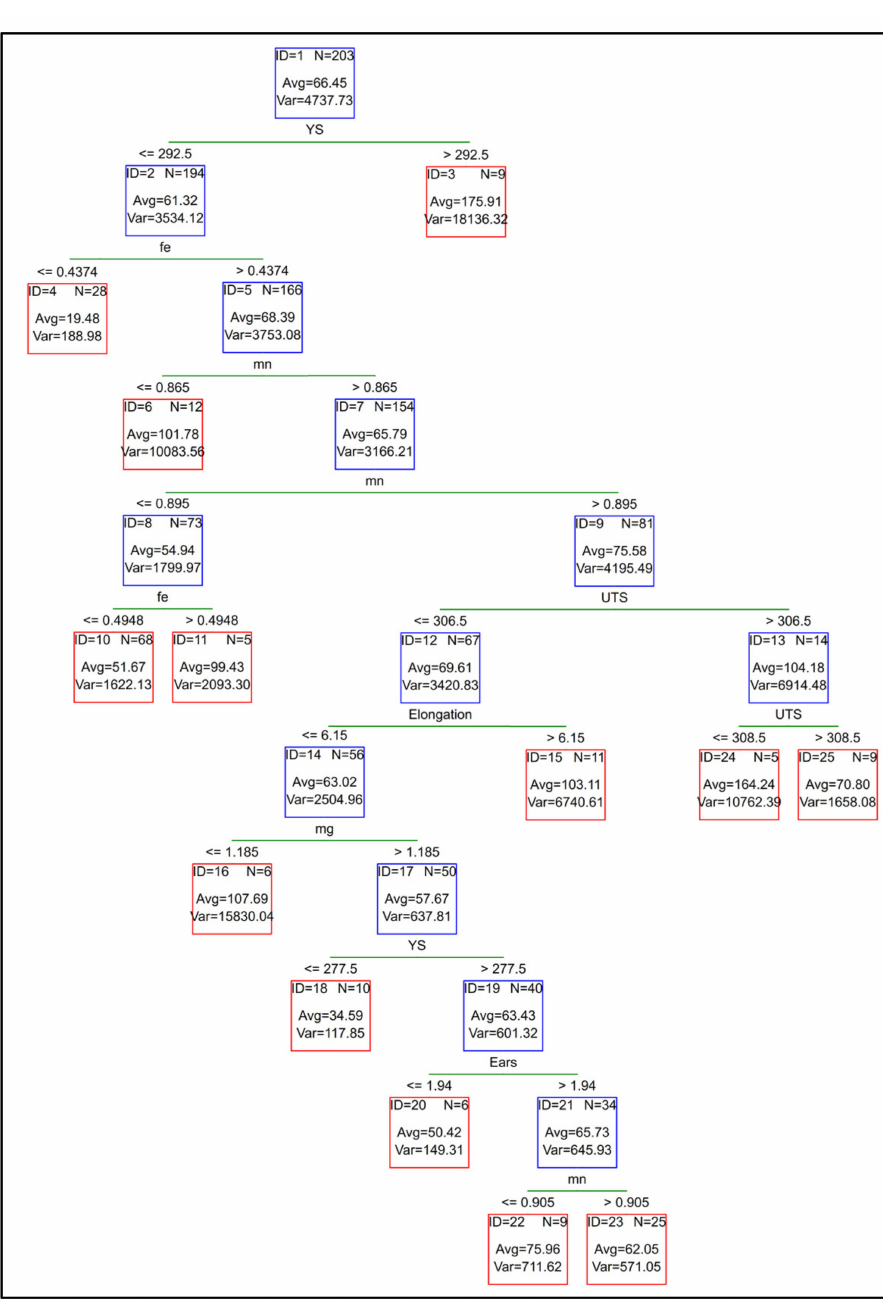
Figure 8. Interactive regression tree for the amount of the short cans, C&RT